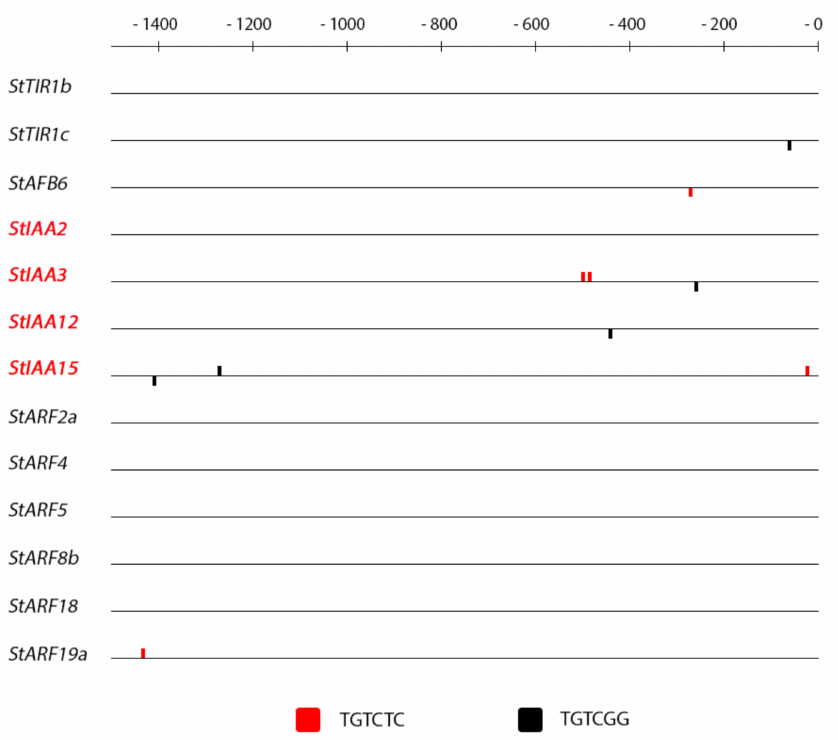
Figure 6. Pattern of auxin-specific cis -elements (AREs) in promoters of auxin signaling potato genes. Names of classical auxin-sensitive Aux/IAA genes are marked red. The scale on the top shows distance in bp upstream the transcription